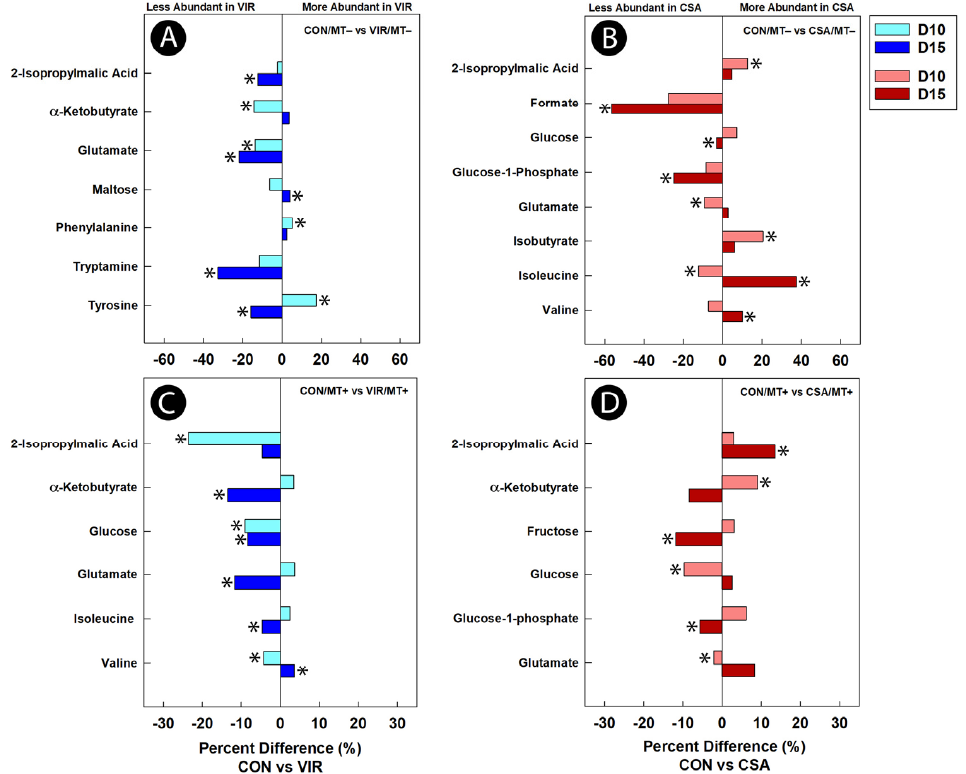
Figure 8. Average percent difference in discriminated metabolites in cecal digesta between broiler chicks that were administered an unamended starter diet (CON), a diet supplemented with vir- giniamycin (VIR), or a diet supplemented with the ceragenin, CSA-44 (CSA). Birds received a microbiota transplant (MT+) or buffer alone (MT–), and samples were analyzed 10 days post-hatch (D10) and 15 days post-hatch (D15). Metabolites that were altered ( p ≤ 0.050) according to univariate Mann–Whitney analysis are denoted with an asterisk. ( A ) CON/MT– vs. VIR/MT– at day 10 and day 15; ( B ) CON/MT– vs. CSA/MT– at day 10 and day 15; ( C ) CON/MT+ vs. VIR/MT+ at day 10 and day 15; ( D ) CON/MT+ vs. CSA/MT+ at day 10 and day 15.